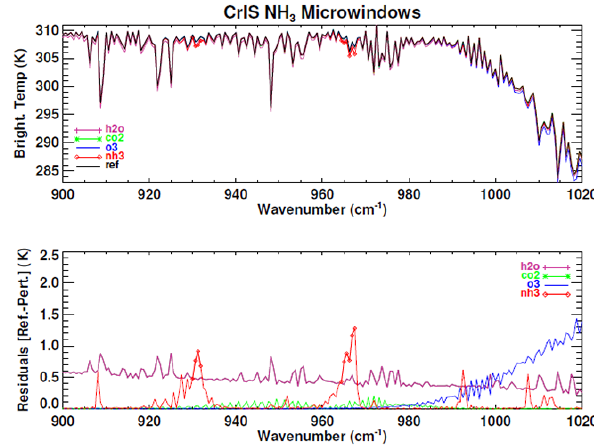
Figure 1. Plot of the CrIS spectral microwindow selection for NH 3 retrievals. The top panel is the model-simulated CrIS observation for a reference atmosphere (plotted in black). Overplotted in colour are various simulated model calculations computed from the refer- ence atmospheric profile perturbed separately by 10% H 2 O, 10% CO 2 , 10% O 3 , and NH 3 increased to a polluted profile. The bot- tom panel shows the residual (reference – perturbation) top of the atmosphere (TOA) brightness temperatures. The diamonds repre- sent spectral points in the NH 3